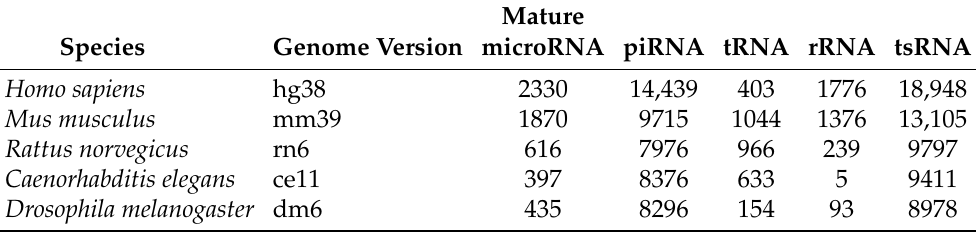
Table 4. Statistics for unique transcript IDs for Integrated Transcript Annotation for Small RNA (ITAS), correction and filtration of intersection inside databases and between databases.